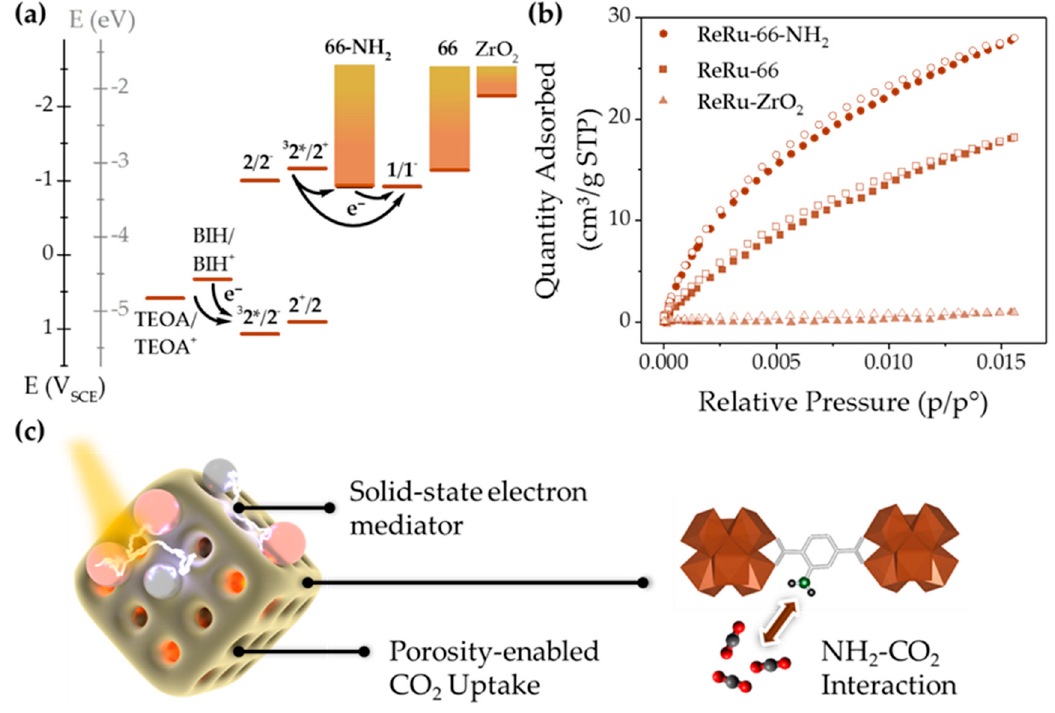
Figure 5. Proposed photocatalysis working principle showing advantages of dye-sensitized MOFs over ZrO 2 . ( a ) Electrochemical potential representation of TEOA, BIH, the dye 2 , and the catalyst 1 to produce an efficient directional electron transfer. Conduction bands of 66-NH 2 , 66 , and ZrO 2 , allowing for electron hopping for MOFs. Values given in V referenced to SCE and eV referenced to the vacuum level [49–51]. ( b ) CO 2 adsorption isotherms at 298 K for ReRu-66-NH 2 (R 2.1) , ReRu-66(R 2.1) , and ReRu-ZrO 2 (R 2.1) . ( c ) Schematic representation of dye- and catalyst-sensitized 66-NH 2 under photocatalytic conditions, yielding increased performance due to electron hopping, intrinsic porosity-based CO 2 uptake, and interactions between polar linker NH 2 groups and CO 2 .